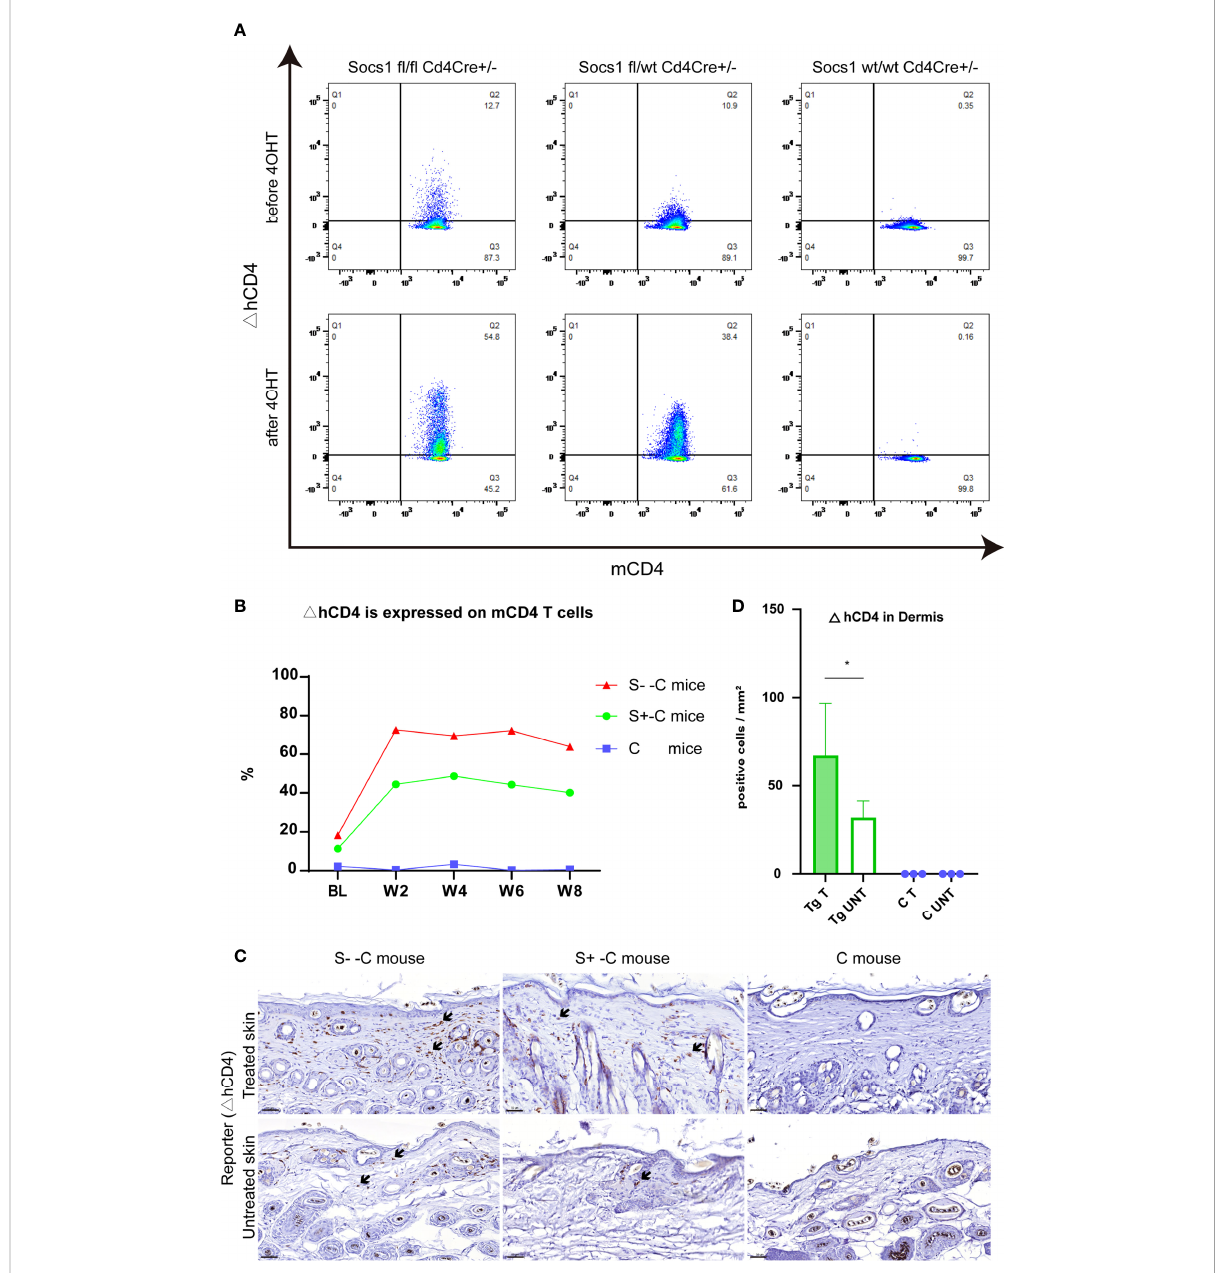
FIGURE 4 Socs1 can successfully be deleted in circulating and skin-homing CD4 T cells of the transgenic mouse by 4OH Tamoxifen application. (A) . Circulating murine Cd4 T cells were analyzed for D hCD4 expression by fl ow cytometry to show Socs1 deletion. Representative fl ow cytometry plots for before and after 4OHT application in Socs1 fl / fl mice Cd4Cre+/-, Socs1 fl /wt Cd4Cre+/- mice and Socs1wt/wt Cd4Cre+/- mice. (B) . Socs1 deletion (measured as D hCD4 expression) in cells as a percentage of total circulating murine CD4 T cells in S – C mice, S+-C mice and C mice during the whole experiment. Each plot is the mean value of mice with the same genotype. BL is baseline. W is week. S – C is Socs1 -/- Cd4Cre+/-; S+-C is Socs1-/wt Cd4Cre+/-; C is control group. (C) . Immunohistochemical staining of D hCD4 to show Socs1 deletion in cells in the murine skin. Representative photomicrographs of D hCD4 expression in treated and untreated skin from S – C mice, S+-C mice and C mice respectively. Black arrows: D hCD4 positive cells. Scale bar: 50 m m. S – C is Socs1 -/- Cd4Cre+/-; S+-C is Socs1-/wt Cd4Cre+/-; C is control group. (D) . Quanti fi cation of D hCD4 positive cells in dermis of transgenic group (S – C mice, S+-C mice) and C mice. Data are presented as mean ± SD (N= 5 in Tg and N=3 in C). *P<0.05. Tg is transgenic group, C is control group. S – C is Socs1 -/- Cd4Cre+/-; S+-C is Socs1-/wt